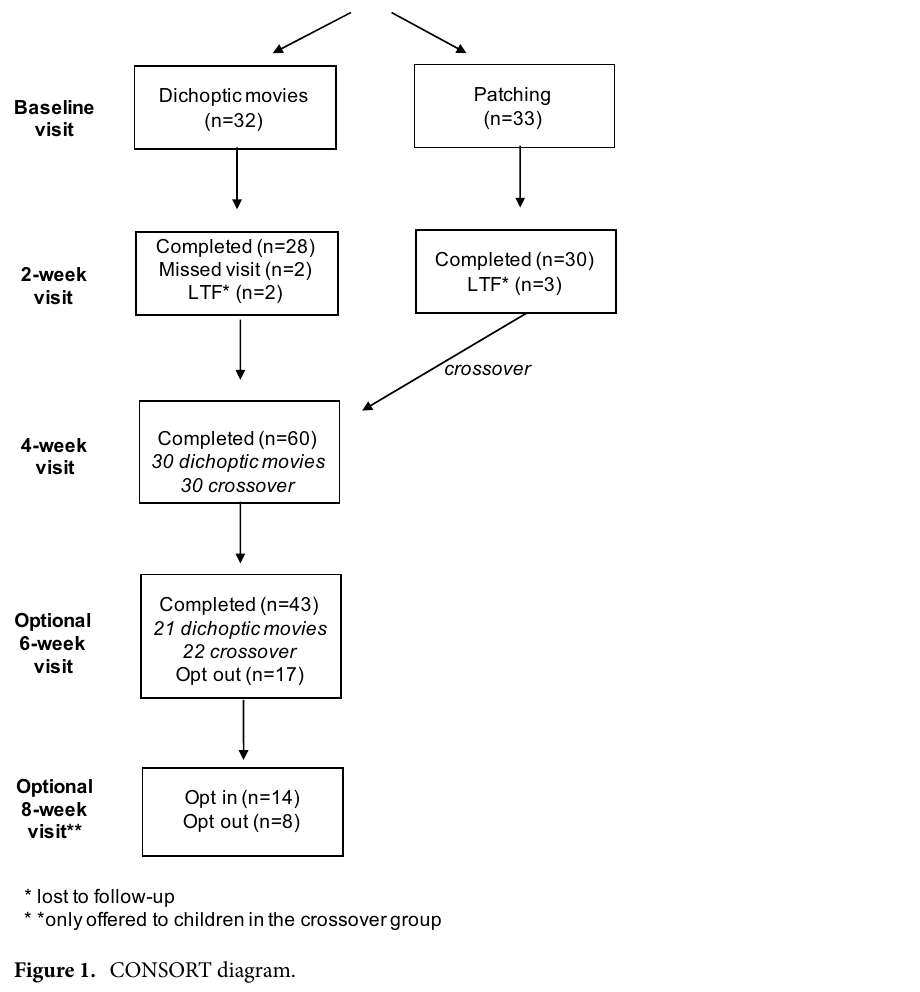
Figure 1. CONSORT